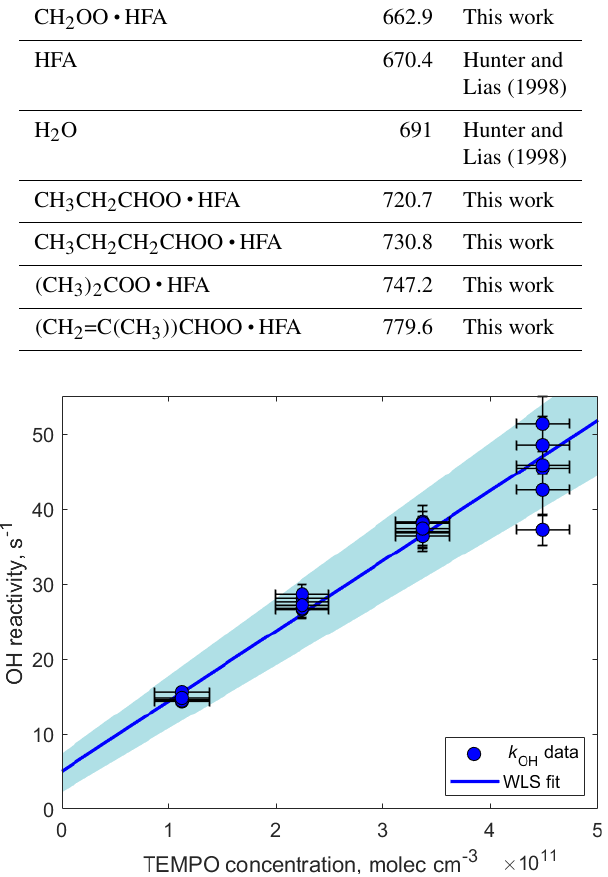
Figure 5. OH reactivity measured as a function of TEMPO con- centration. The slope determining the reaction rate coefficient k TEMPO + OH = ( 9 . 3 ± 0 . 9 ) × 10 − 11 cm 3 molecule − 1 s − 1 was cal- culated using weighted least squares (WLS). The 95% confidence interval was estimated via a Monte Carlo simulation ( N = 5000) and is shown using blue shading. The intercept ( 5 . 1 ± 24 ) s − 1 can be explained by the presence of other OH reactants such as O 3 , NO, NO 2 , and